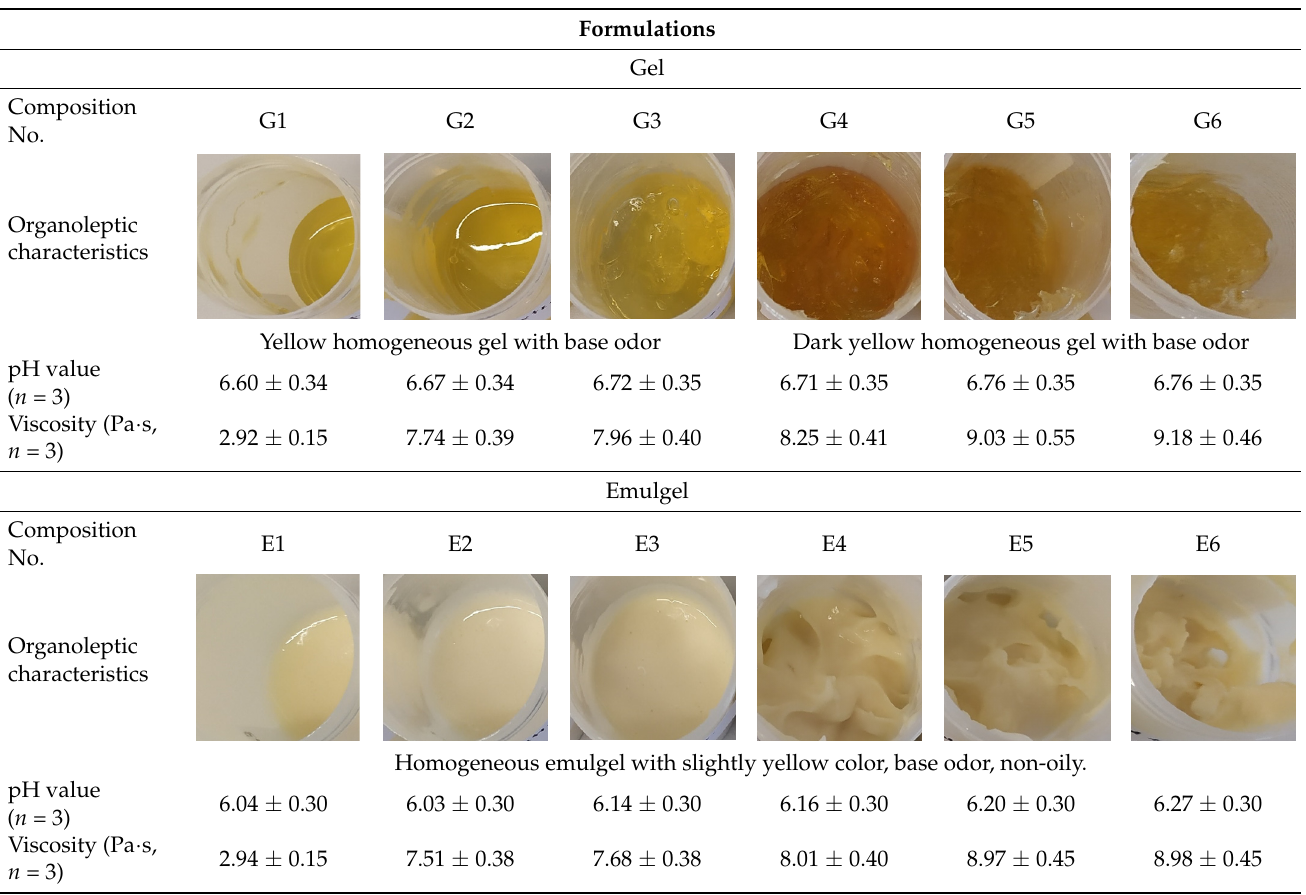
Table 2. Organoleptic characteristics and physicochemical parameters of gels and emulgels with 1% AE.